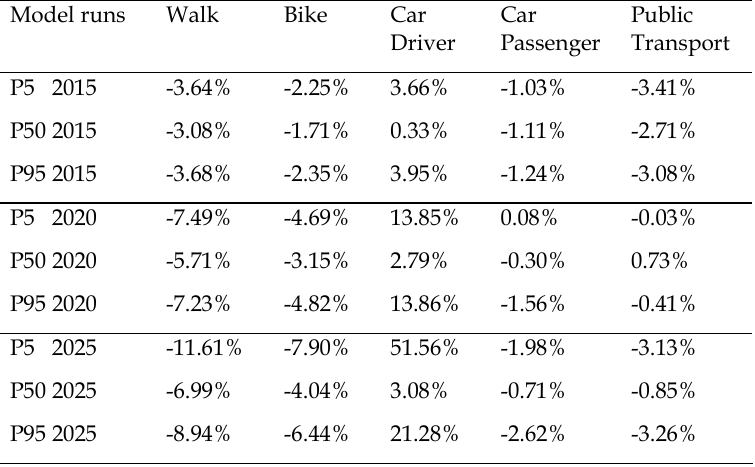
Average trip length by mode (percentage change from Base